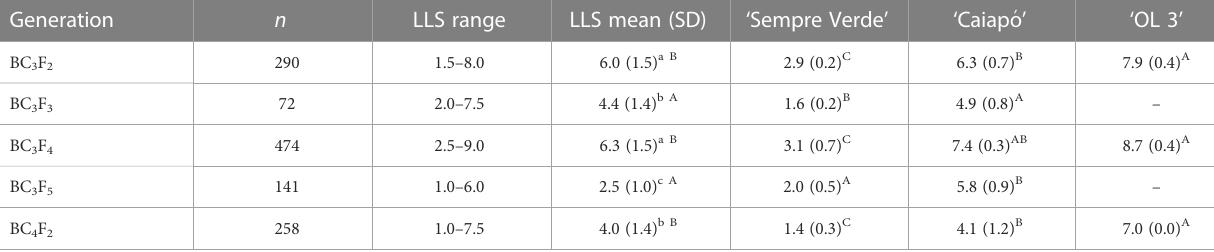
TABLE 1 Number of plants evaluated ( n ), LLS score range, and means of plants with introgressions from Arachis stenosperma and A. magna of generations BC